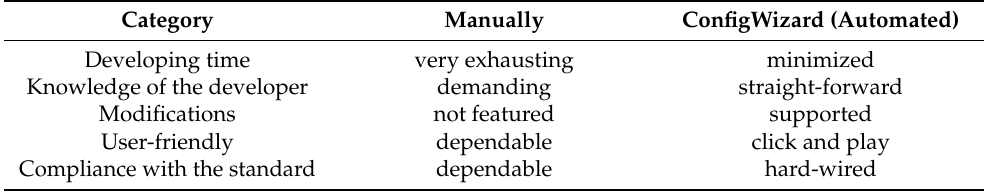
Table 2. Comparing the AAS formation options.